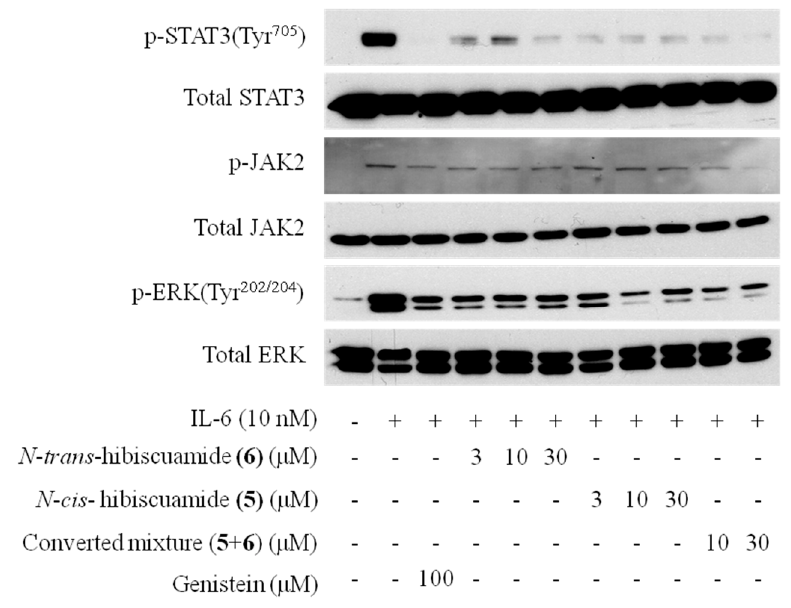
Figure 5. Effects of compounds 5 and 6 and their converted mixture ( 5 + 6 ) on the STAT3, JAK2 and ERK Phosphorylation by IL-6.